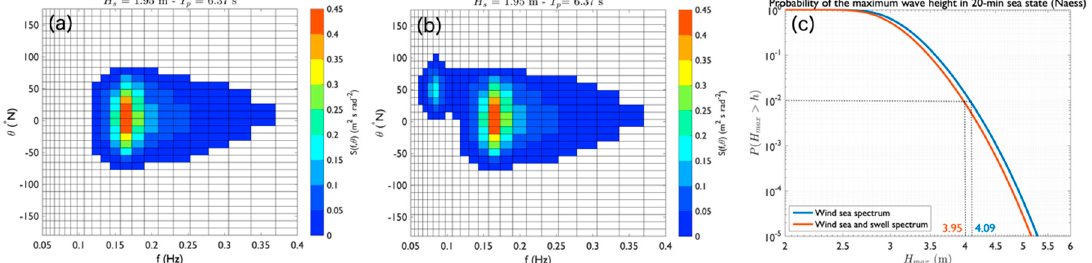
Figure 7. Directional spectrum shape and probability of maximum wave heights in the sea state. ( a ) Wind sea spectrum ( H s : significant wave height; T p : peak period). ( b ) Wind sea and swell spectrum. ( c ) Extreme value probability of the maximum wave height in a 20 min sea state given the two spectra in the left and middle panels. Parent probability distribution is Naess’ [43], accounting for the bandwidth of the spectrum in the frequency range.